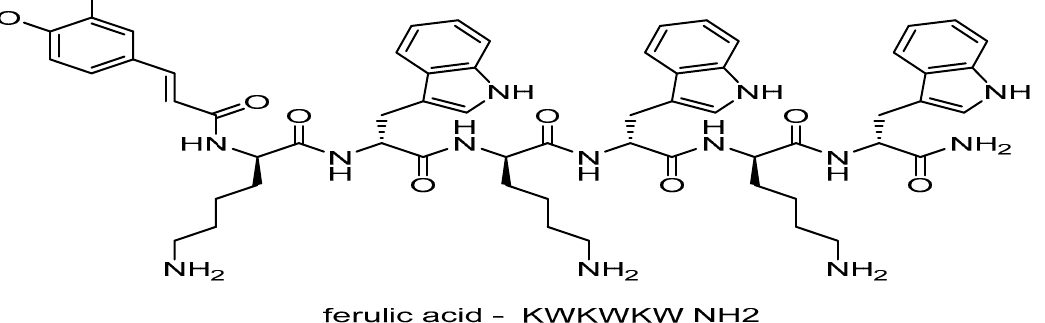
Figure 1. The overall structure of Tryasine, which has a net positive charge of +2 and a molecular weight of 1136.34 g/mol.